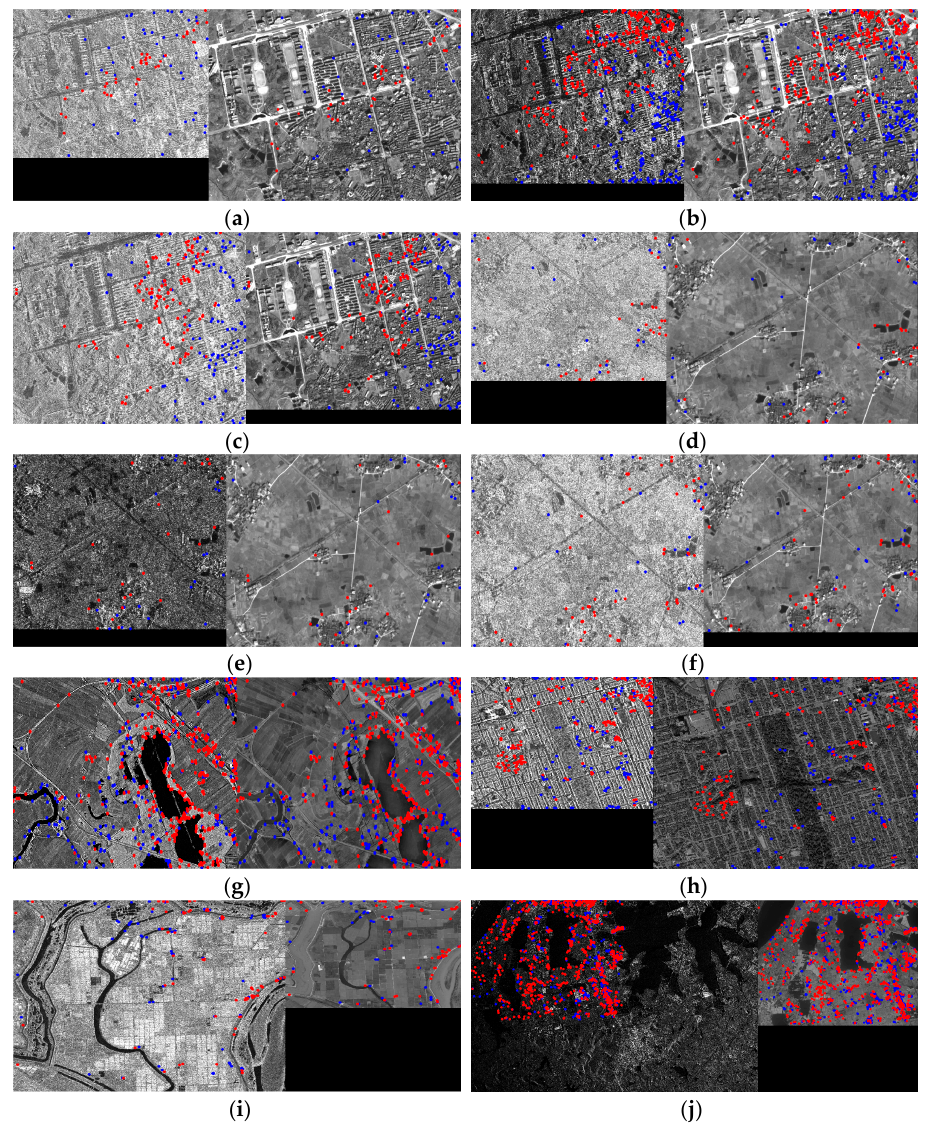
Figure 11. Matching results of the proposed method between SAR and optical images. In the matching results, correct matches are marked as red points. False matches are marked as blue points. ( a )–( j ) are the matching results of the proposed method for the third to the twelfth pairs of images described in Table 2,